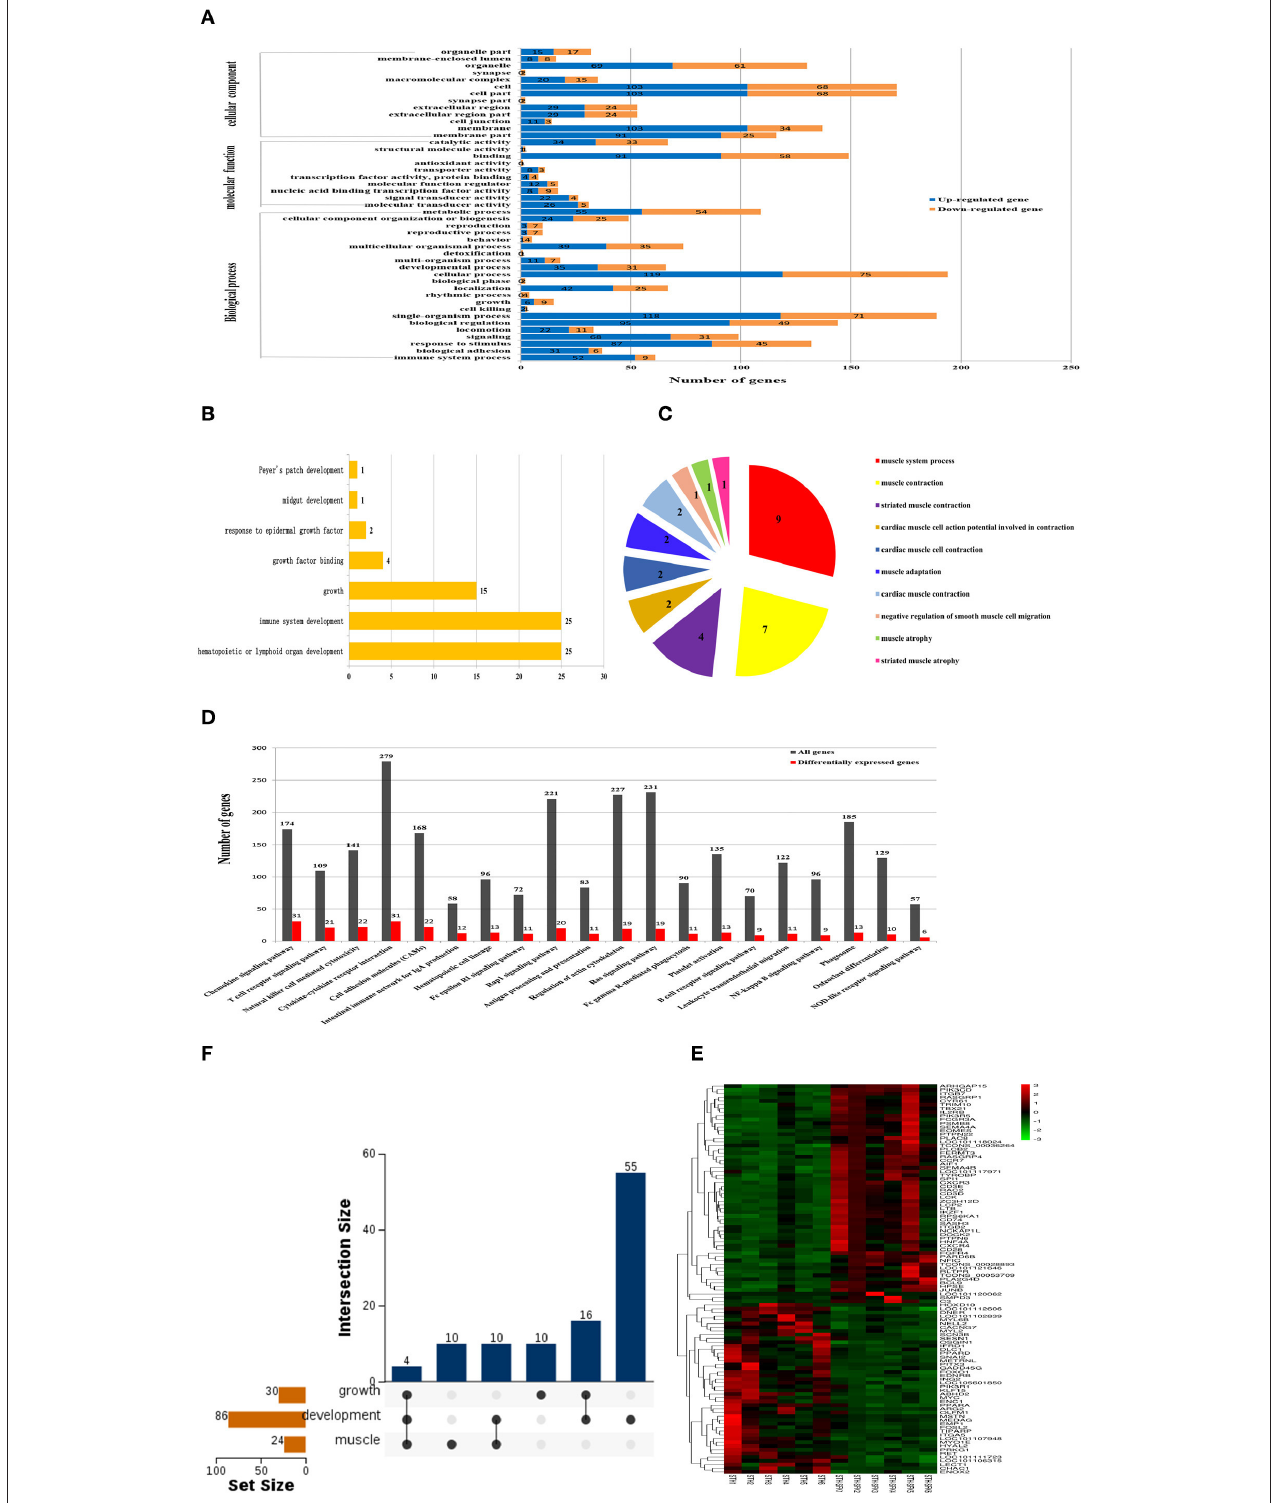
FIGURE 4 | Screening of candidate genes related to growth and meat quality of STH and STH × SFK sheep populations. (A) GO functional classification of DEGs ( P < 0.05). (B) GO analysis of candidate DEGs related to sheep growth and development. (C) GO analysis of candidate DEGs related to sheep meat quality. (D) Determine the important route based on the DEG of two sheep ( P < 0.05). (E) Candidate gene heat map. (F) UpSet Venn diagram related to growth and development and meat quality.